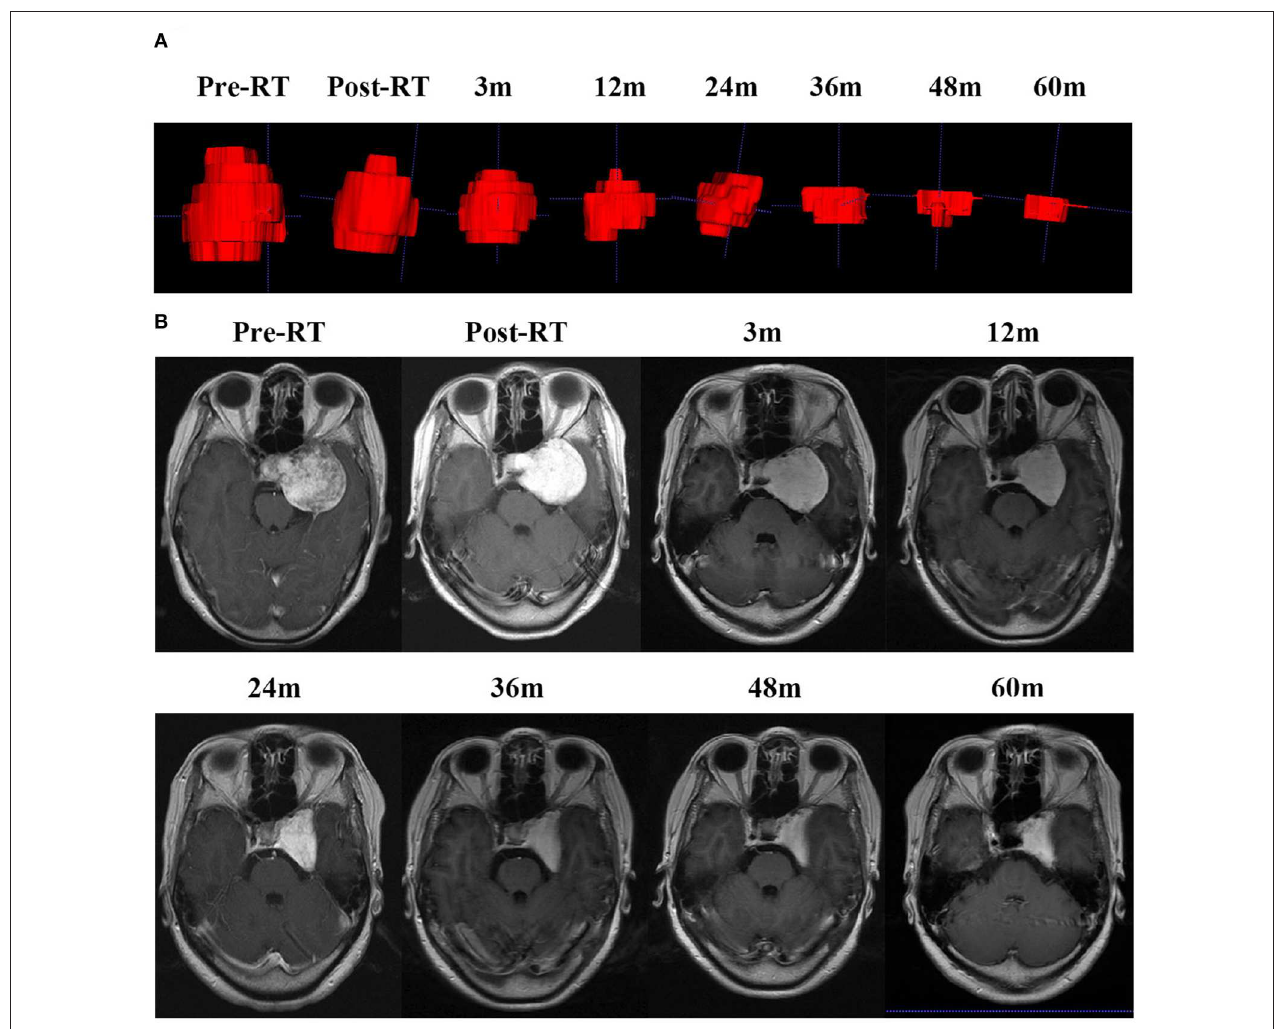
FIGURE 2 | CSH of patient 7 kept decreasing even 5 years later. (A) The 3D imaging of the mass before RT and at different times of follow up after RT. (B) MRI scan before RT, the day after RT completion and at a different time of follow up after RT.